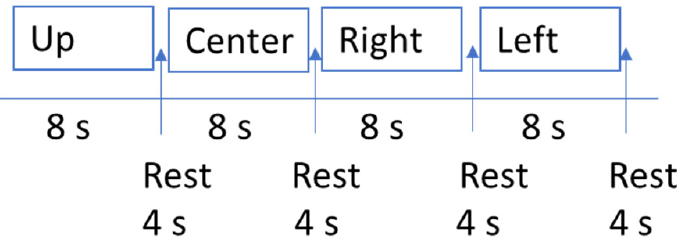
Figure 3. Timing of a single SSVEP trial.